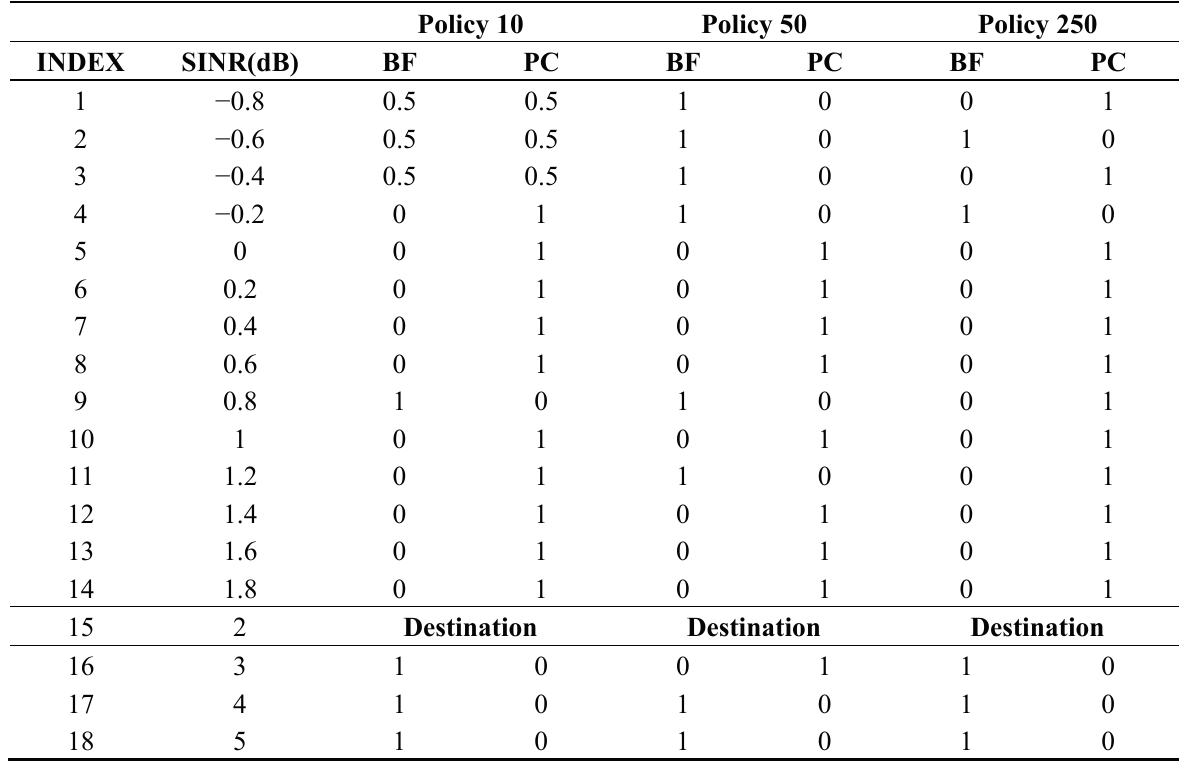
Table 2. Policy Improvement of the